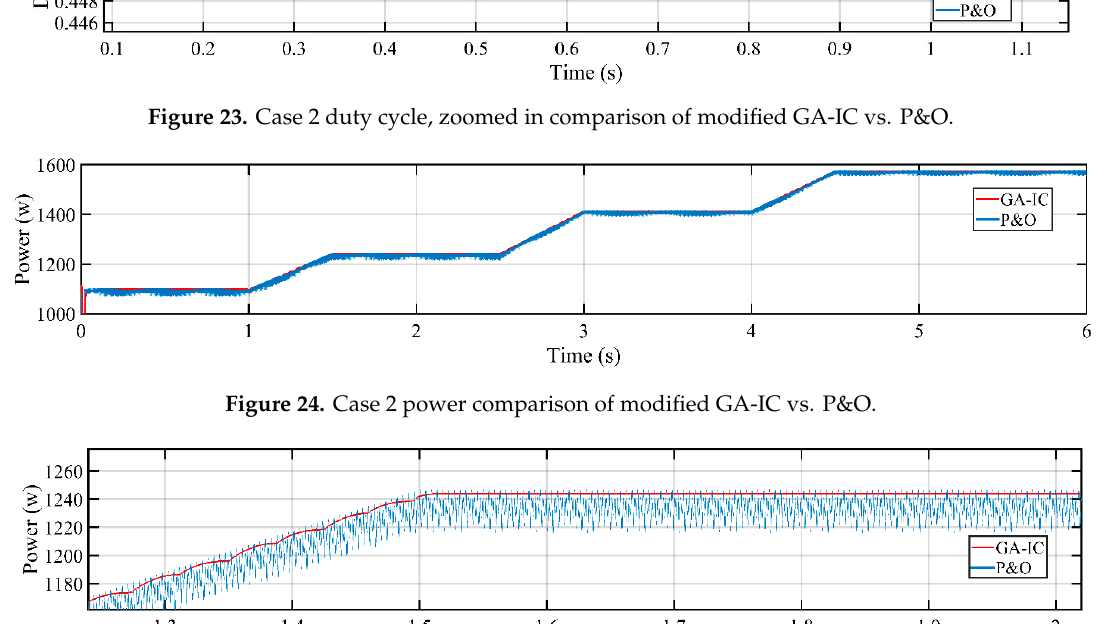
15 of 24 Figure 20. Case 1 current comparison of modified GA-IC vs. P&O. Figure 21. Case 1 current, detailed comparison of modified GA-IC vs. P&O. 4.2. Case 2 This case gives the most effective test pattern for P&O to compete with the proposed GA-IC technique. The irradiance pattern is presented by Figure 12, showing the gradual and continuous increase in irradiance levels. Starting from t = 0 to 1 s and 700 (cid:1875)/(cid:1865) (cid:2870) , from 1–1.5 s it is gradually changed from 700 (cid:1875)/(cid:1865) (cid:2870) to 790 (cid:1875)/(cid:1865) (cid:2870) and remains constant till 2.5 s. Similarly, it changes from 790 to 898 (cid:1875)/(cid:1865) (cid:2870) in the next 0.5 s. Eventually, it reaches 1000 (cid:1875)/(cid:1865) (cid:2870) . The rate of change of in the irradiance is kept at 216 watt/s. Fast recovery is needed to minimize power loss due to lag in tracking the MPP. Tracking the MPP with efficiency is the desired outcome of this test pattern. The control action given by duty cycle is compared in Figure 22 and detailed zoom in Figure 23. The efficiency of P&O and GA-IC is 98.5% and 99.2%, respectively, for power conversion as shown in Figures 24 and 25. The response time of the proposed GA-IC is 14.78% faster. This indicates that the proposed technique is faster in terms of tracking a gradually changing MPP. Moreover, the oscillations caused by P&O, which continuously dissipate, on average, 26.8 watts of power, are reduced by 97.3%. This significant improvement in design saves up to 25 watts of power, adding another 1% of efficiency in power conversion by MPPT. Overshoot in both cases is designed to be at a minimum. This is done by gradually adding irradiance from a lower to a high level. The reason for such a choice is to provide a good understanding of the tracking capability of the GA-IC under a transitioning MPP. The voltage and current transients are given by Figures 26–29.